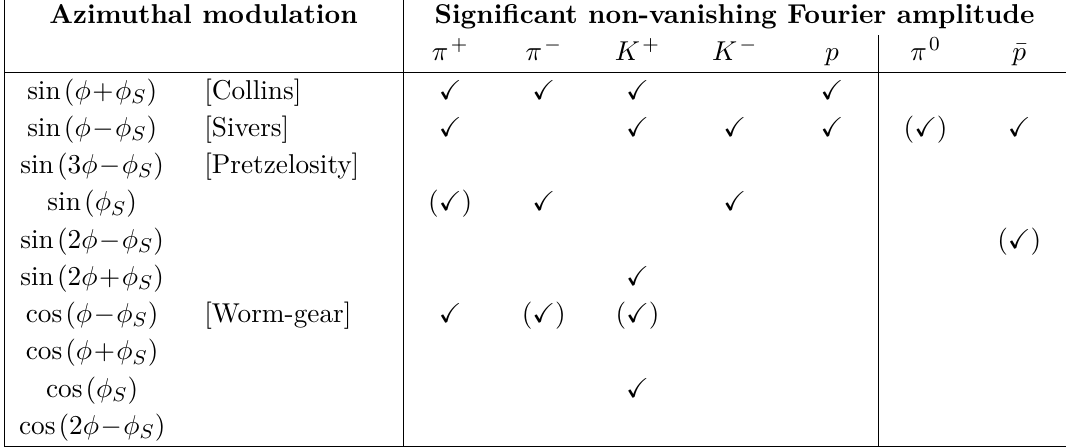
Table 9 . The various azimuthal modulations of the semi-inclusive cross section and those hadron species whose corresponding Fourier amplitudes are incompatible with the NULL hypothesis at 95% (90%) confidence. Antiprotons and π 0 are given separated in the last two columns to indicate that the statistical test of those is based on the one-dimensional projections and hence restricted to using only seven data